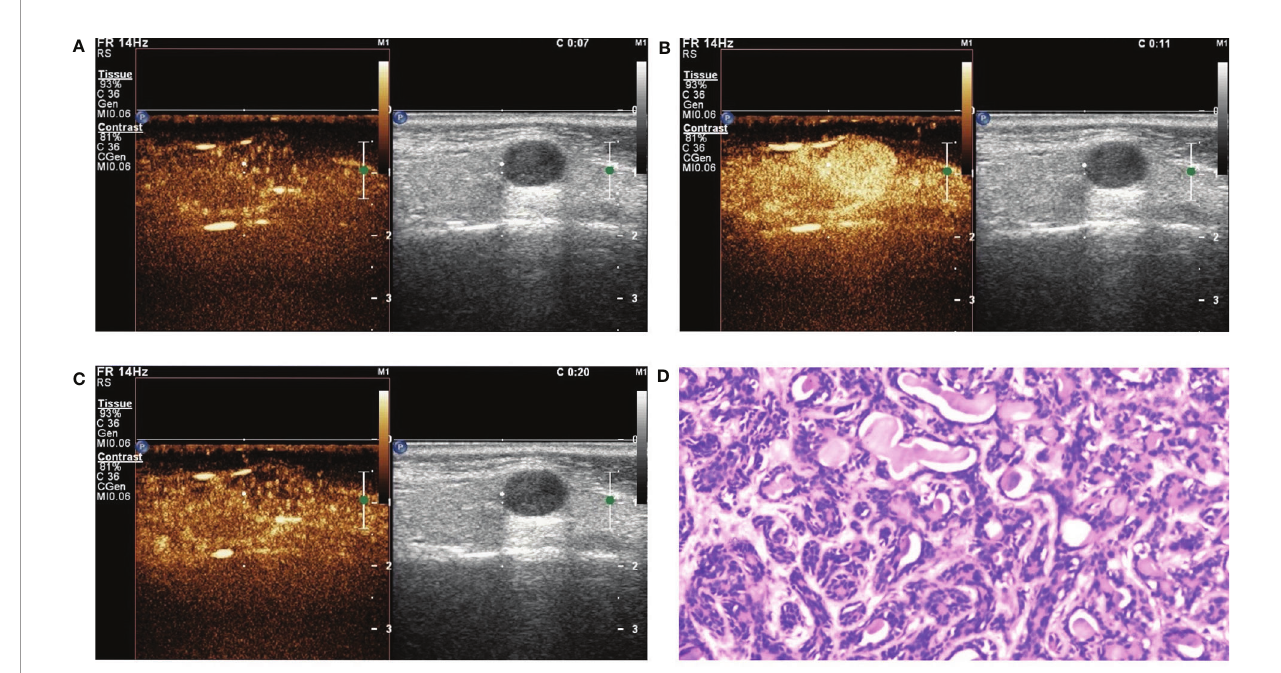
FIGURE 4 | Basal cell adenoma (BCA) in contrast-enhanced ultrasound (CEUS). The qualitative CEUS showing the mass with high intensity and homogeneous enhancement. The perfusion pattern of contrast agent was “ fast in and fast out ” ( A -early phase; B -middle phase; C -late phase). (D) H&E stain (original magni fi cation